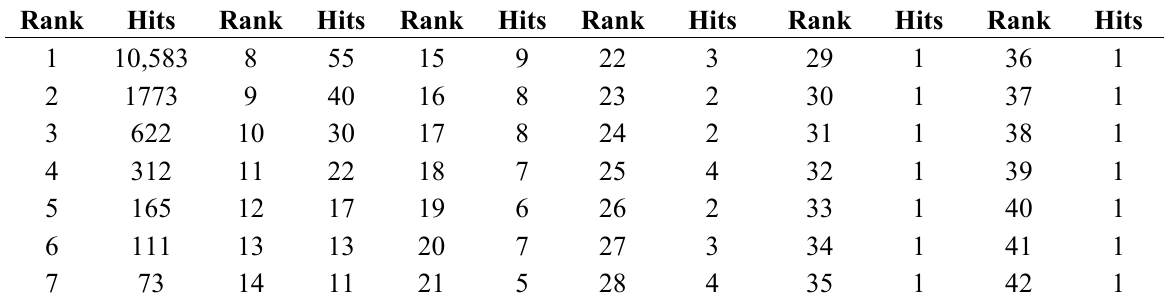
Table 1. Results of the matching precision tests (using each dataset molecule as the query).